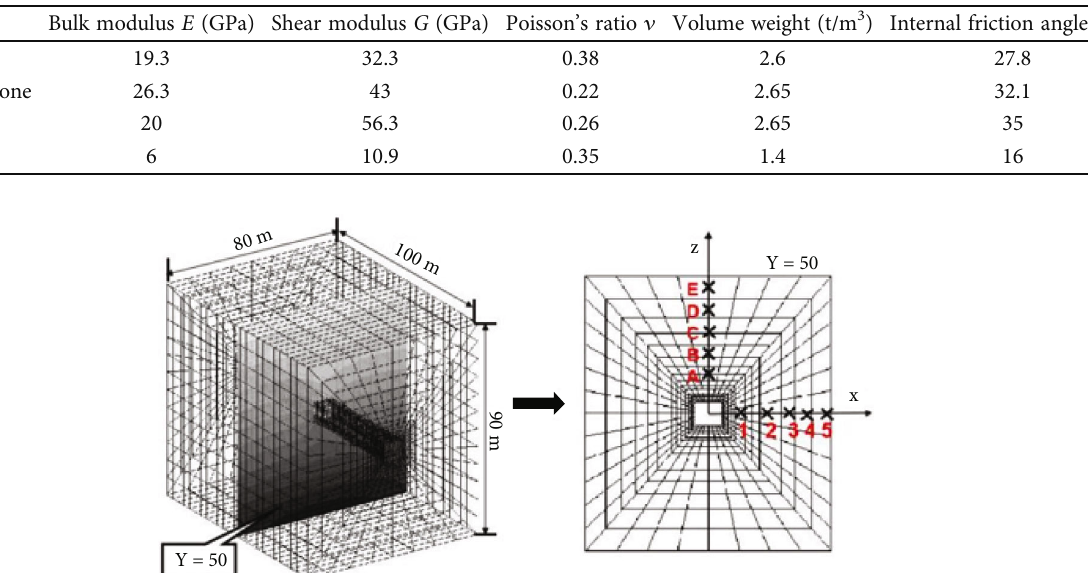
Table 1: Mechanical parameters of the principal rock strata.